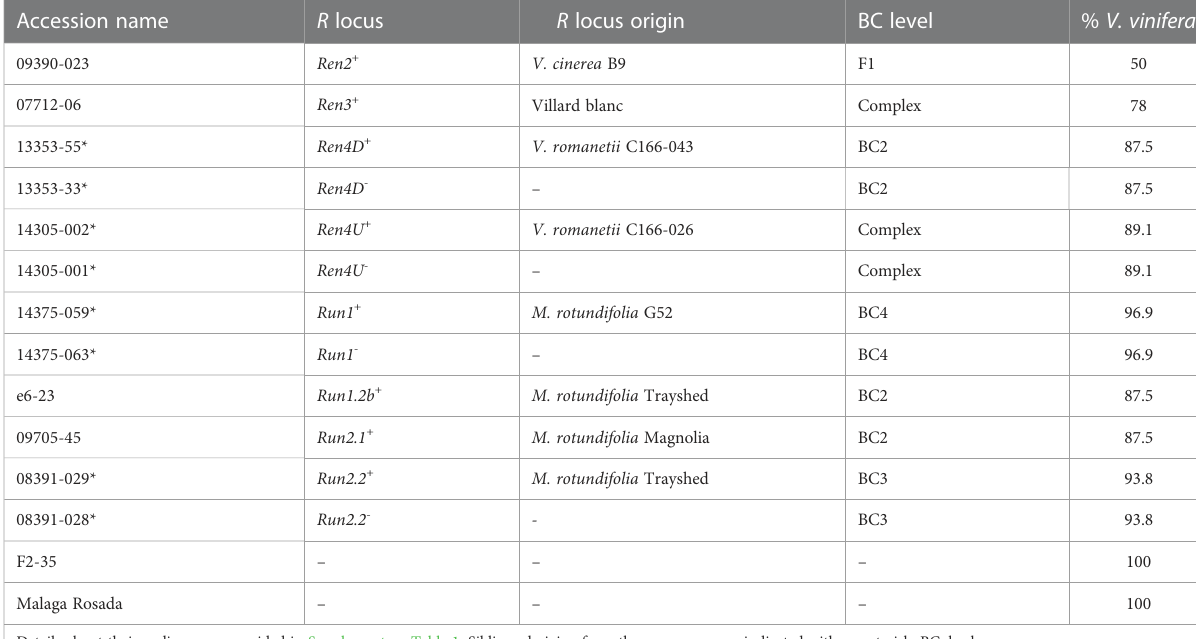
TABLE 1 Description of the fourteen grape genotypes used in this